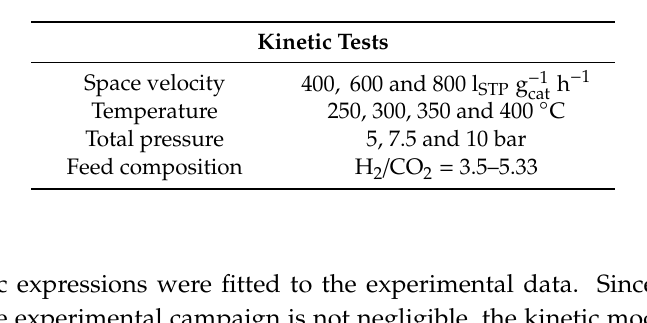
Table 10. Kinetic test